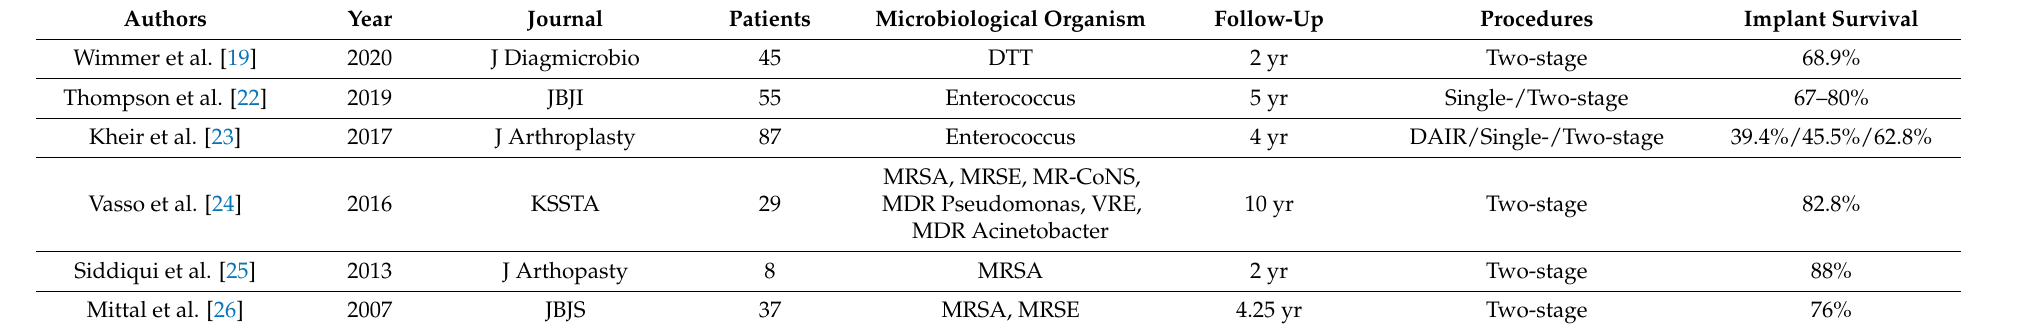
Table 5. Implant survival rates after PJIs associated with difficult-to-treat